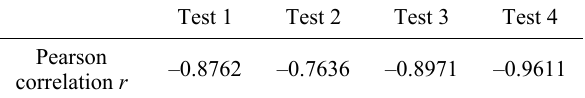
Table 3 Correlation coefficient of R and RR during the friction